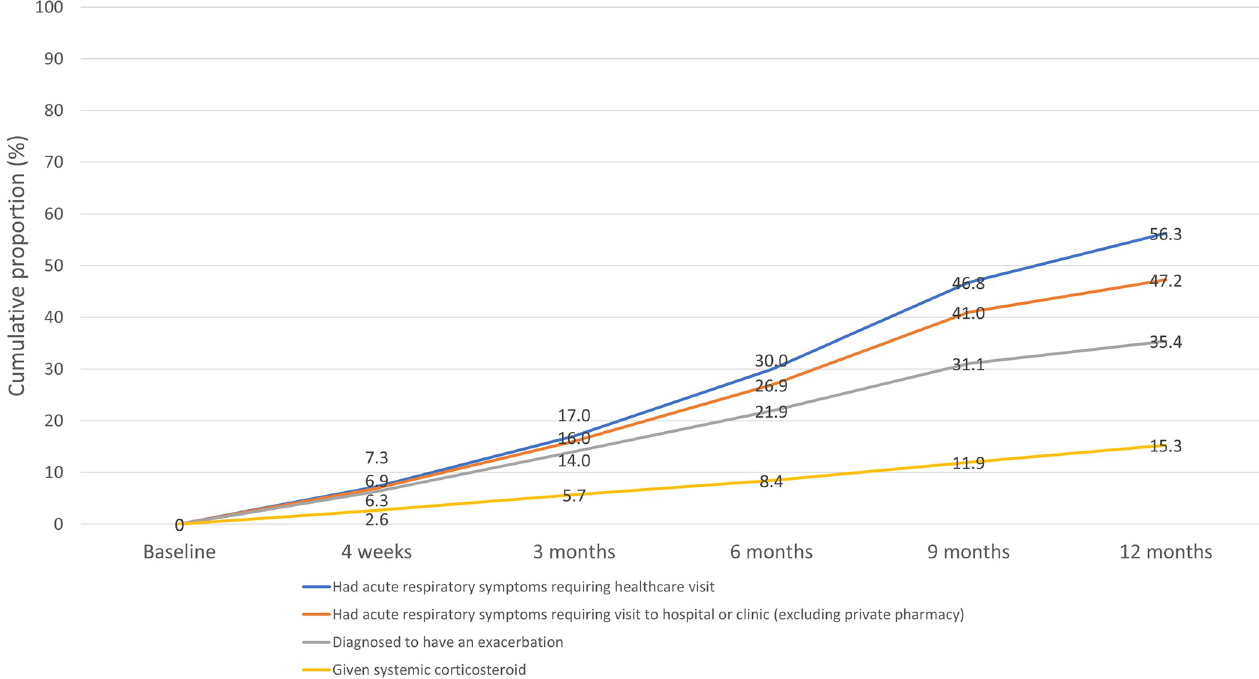
Fig 3. Proportion of participants with at least one exacerbation over study period.